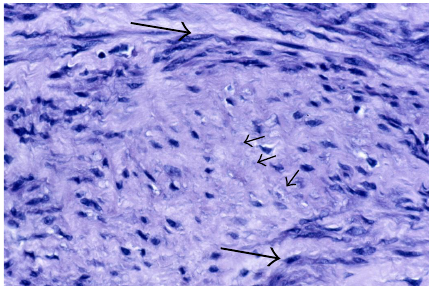
Figure 10: Nuclear atrophy. In this image from a late phase fibroid, the myocytes at the top and lower right (long arrows) retain some visible cytoplasm and nuclear length, while the cells in the center of the fibrotic matrix show little remaining cytoplasm and nuclei that are small, variably shaped, and appear to be atrophic. In addition, near the most central portion of this image there are a few pale staining, barely visible nuclei of cells that are assumed to be nonviable (short arrows). Original magnification: